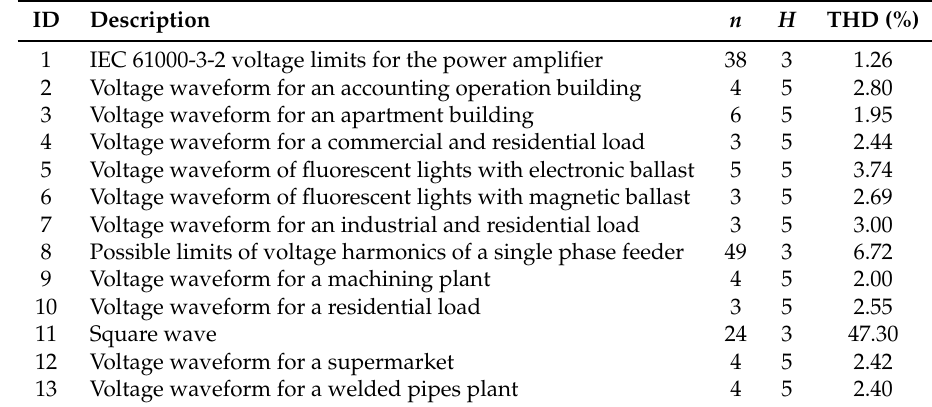
Table 2. Validation test waveforms, taken from [28], showing the total number of harmonic components included n , the most intense harmonic order H , and the calculated THD.